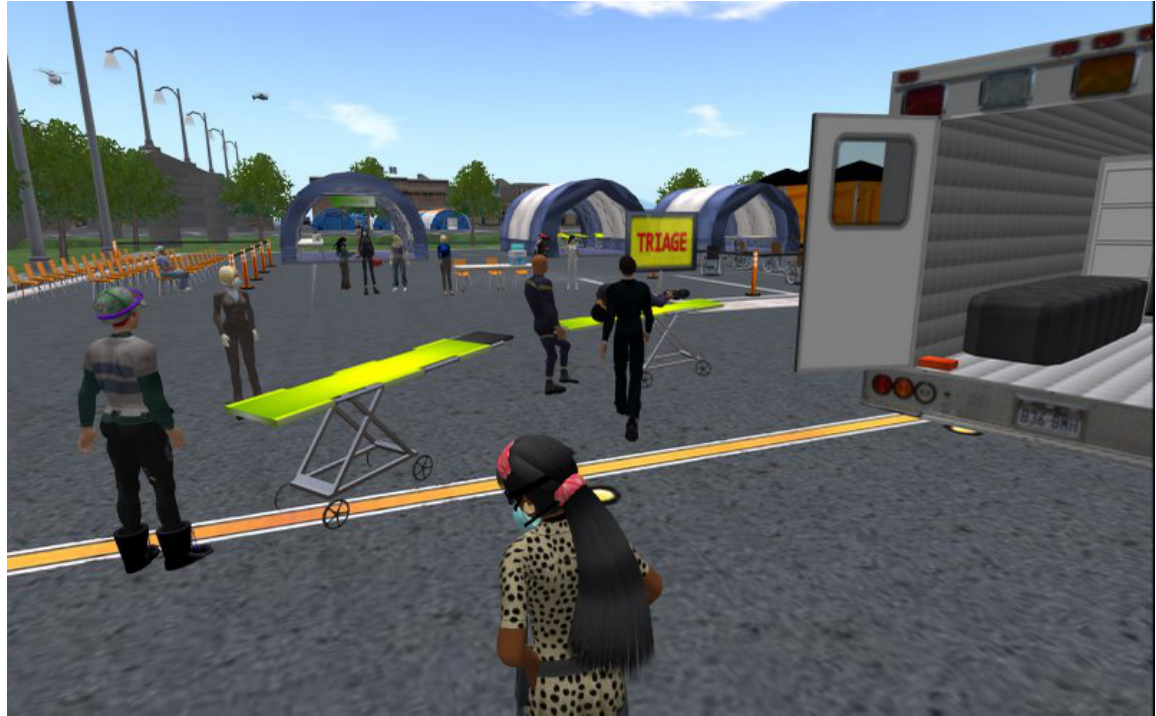
Figure 3. Assessing and triaging patients on arrival at the alternate health care facility deployed on a parking lot of a